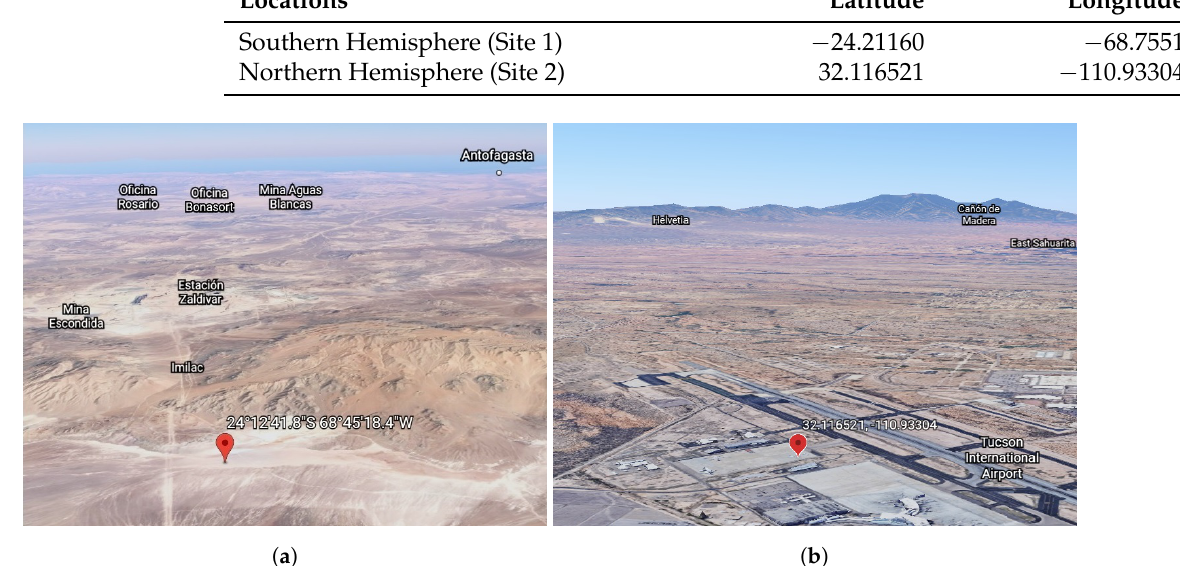
Figure 3. Selected locations in the southern hemisphere ( a ) and northern hemisphere ( b )